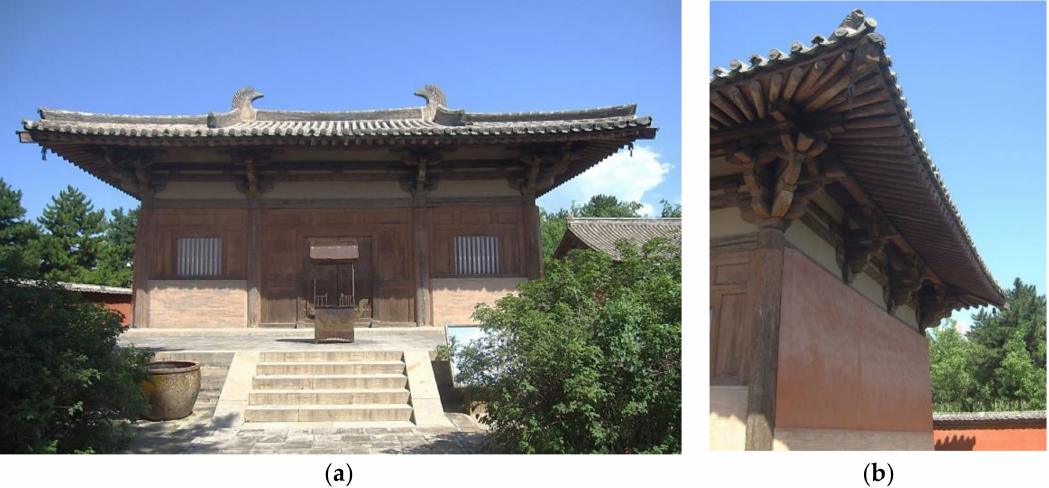
Figure 2. Photographs of the Nanchan Temple (source: Wikipedia). ( a ) Frontal view. ( b ) Lateral